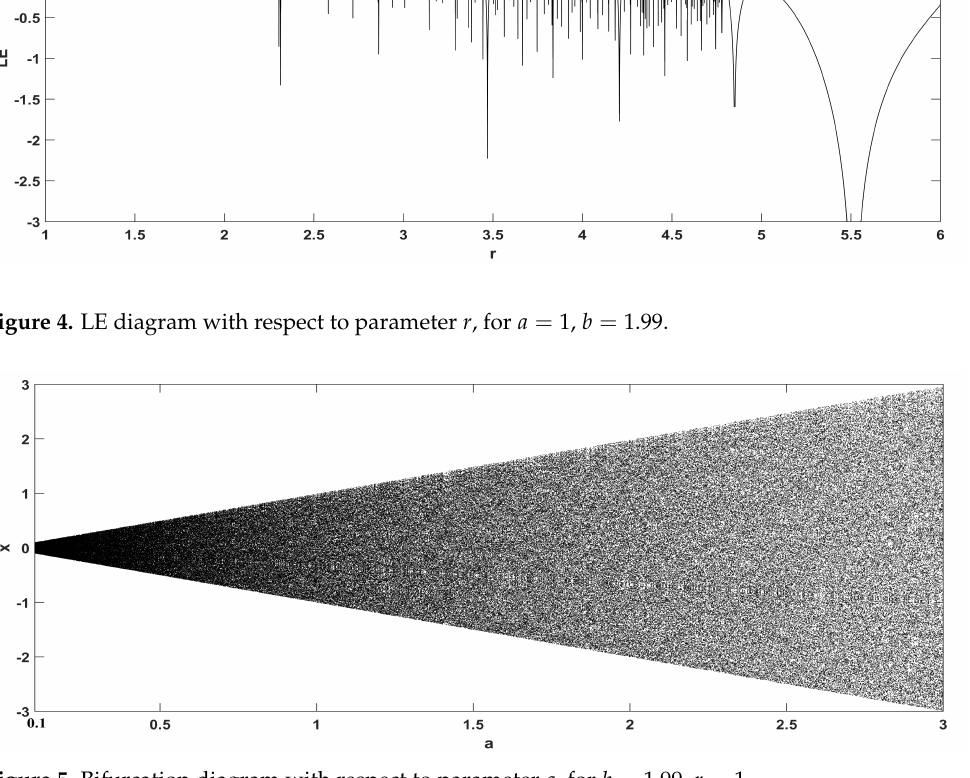
Figure 5. Bifurcation diagram with respect to parameter a , for b = 1.99, r = 1.